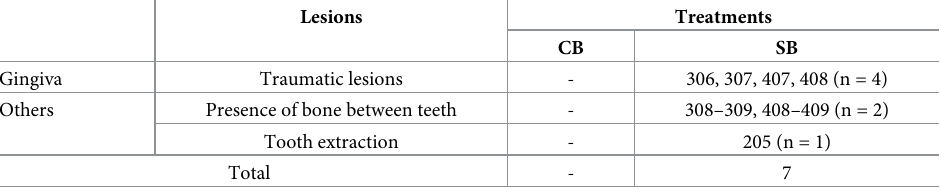
Table 2. Number and localization of dental injuries in adult Beagle dogs after supplementation of bones with dif- ferent densities for 13